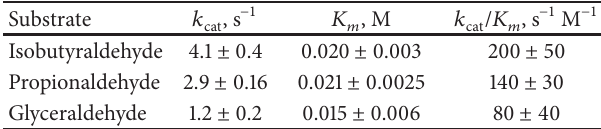
Table 3: Kinetic parameters of AlDHPyr1147 in reactions with different aldehydes. Conditions: 50 mM sodium pyrophosphate buffer, pH 8.8, 100mM NaCl, and 0.3mM NADP+, 60 ∘ C.